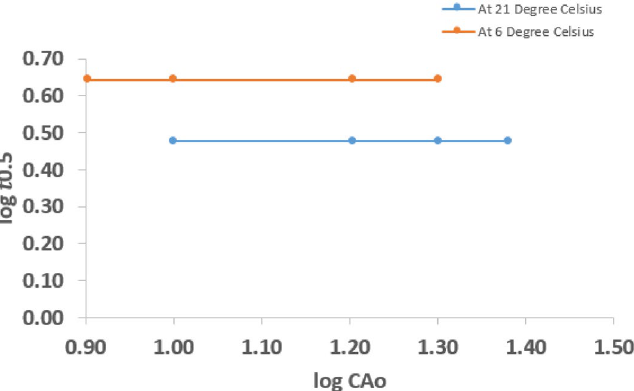
Figure 4. log t 0.5 vs log C Ao graph for hydrolysis of CV at 0.016 M NaOH and variable temperature.